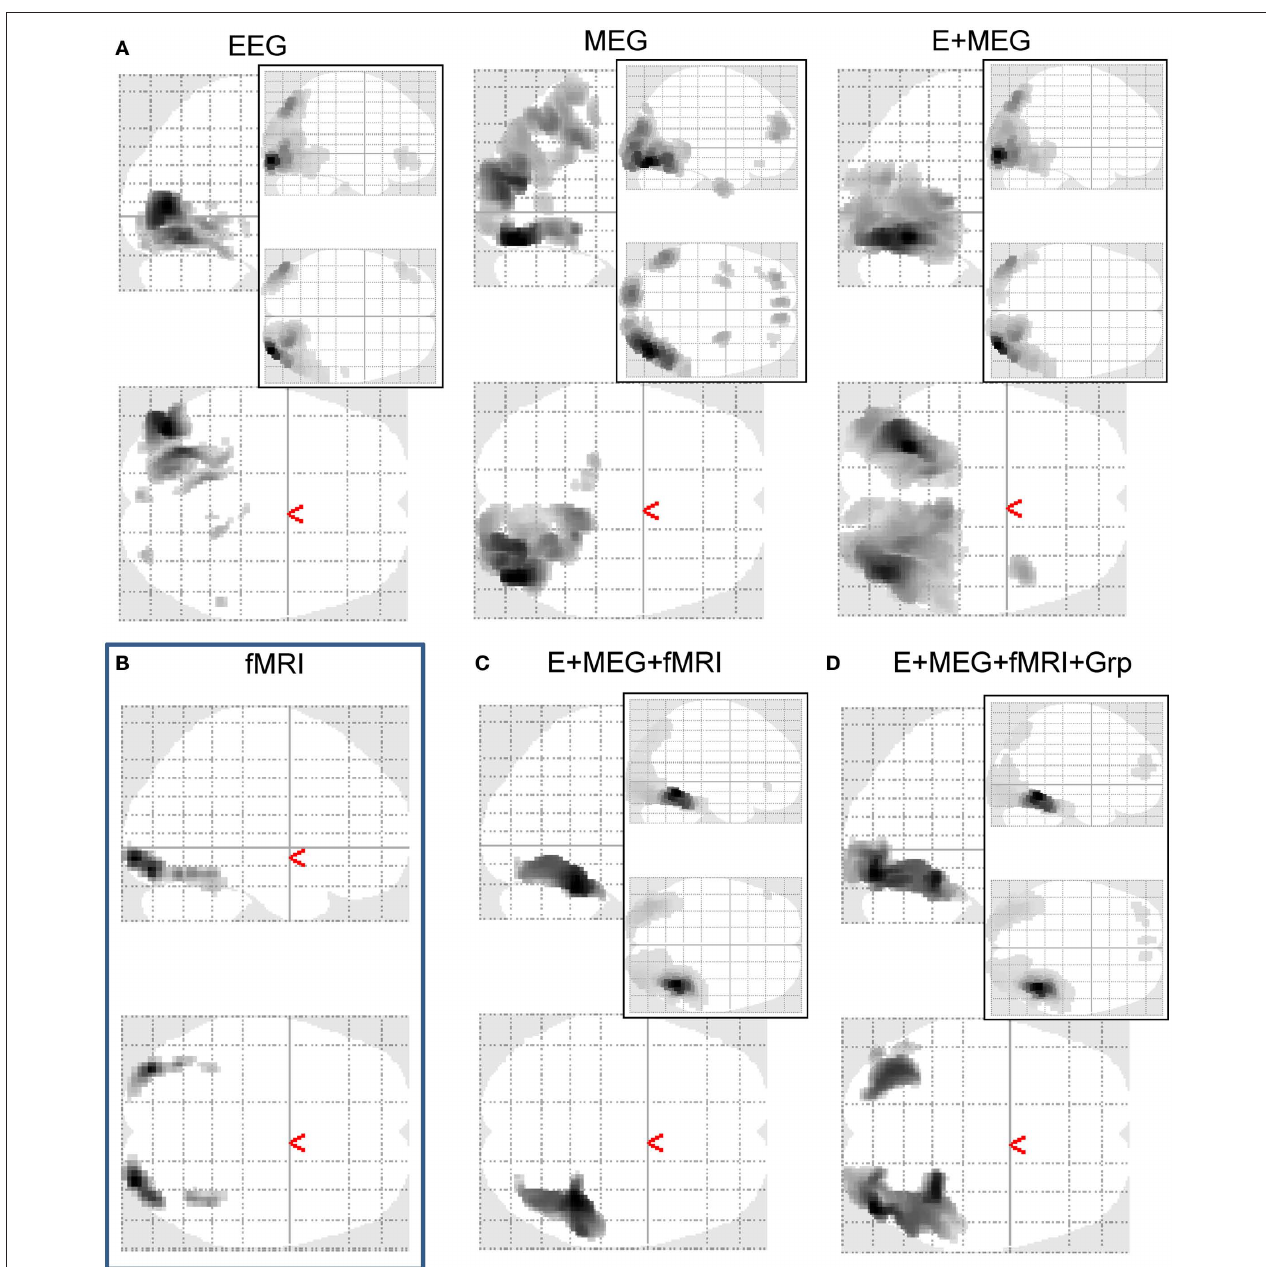
EEG data alone, MEG data alone, or from fusing EEG and MEG data in the “bimodal” model of Figures 4–5 . (B) shows the results of the same contrast but on the fMRI data (though two-tailed, and at a higher threshold of p < 0.05 corrected for multiple comparisons). (C) shows the results of inverting EEG and MEG data after the addition of three fMRI priors [those in (B) ] using the generative model shown in Figure 7 . (D) Shows the results of group- optimization of the fMRI priors used in (C) , using the generative model shown in Figure